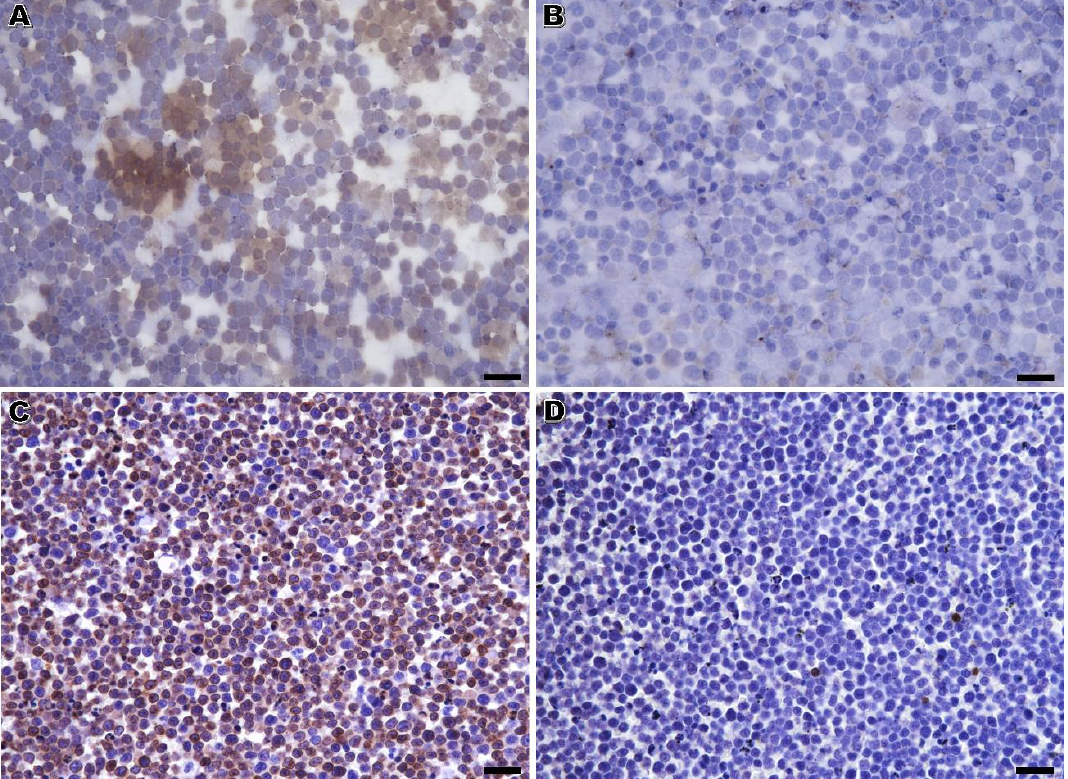
Figure 2. Pleural effusion in a cat compatible with lymphoma. ( A , B ) Immunolabeling on Romanowsky-stained cytology. None of the cells showed immunoreactivity to CD3 ( A ) or PAX5 ( B ), and background staining was observed ( A ); ( C , D ) Immunolabeling of CB on matched cell tube block sections. Positivity for CD3 on the cell surface was observed in more than 75% of the lymphocytes